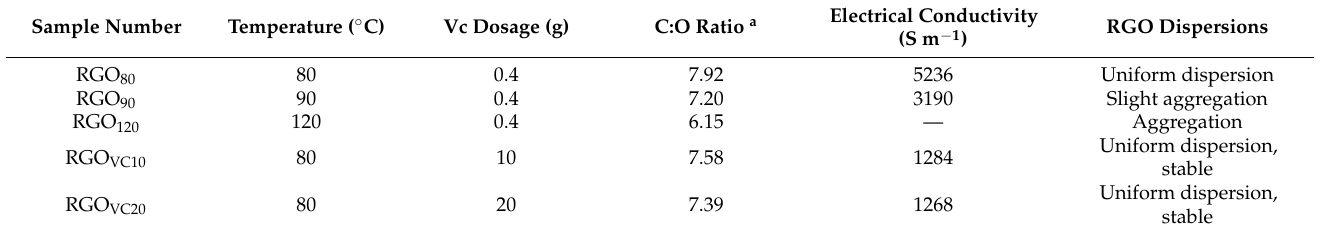
Table 3. RGO at different temperatures and dosages of reducing agents in the gradient solvent system.